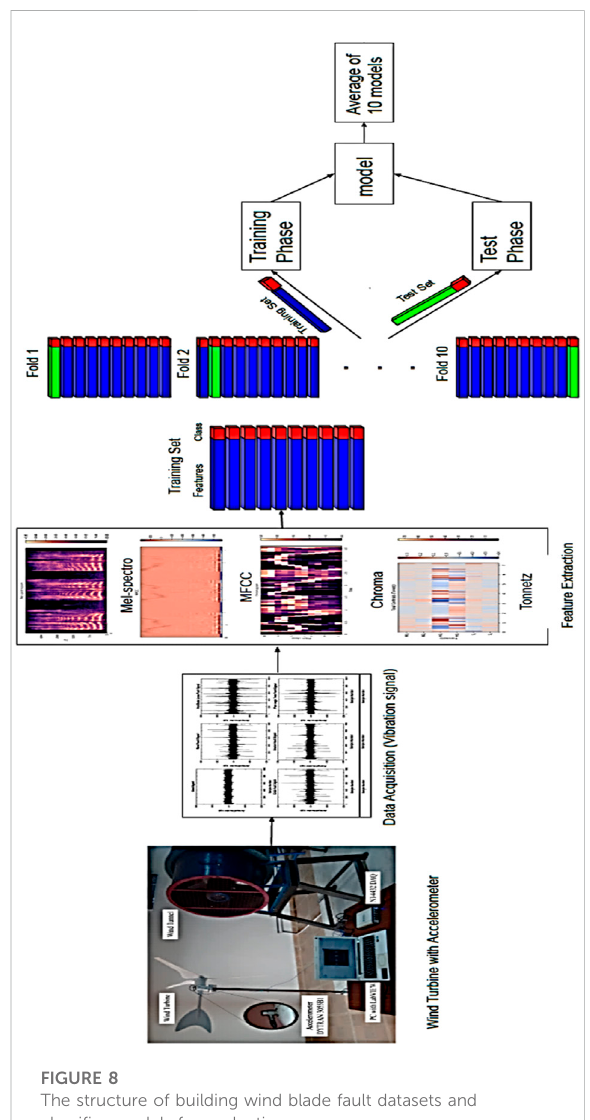
FIGURE 8 The structure of building wind blade fault datasets and classi fi er models for